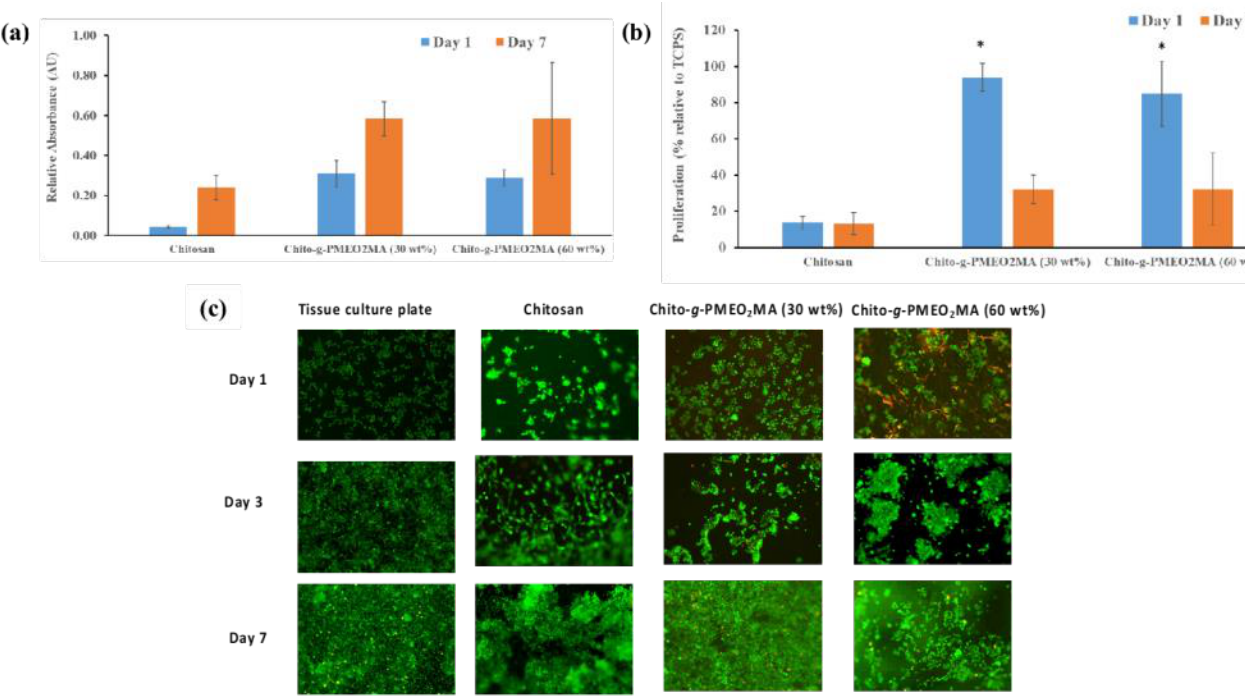
Figure 5. RAW 264.7 macrophages on TCPS, chitosan, and modified chitosan films. ( a ) Proliferation of RAW 264.7 cells on modified and unmodified chitosan films, relative absorbance of XTT in arbitrary units (AU). Mean ± SD, n = 4 or 5. ( b ) Proliferation of RAW 264.7 cells on chitosan films relative to the control surface (TCPS), as measured by XTT. Mean ± SD, n = 4 or 5; * indicates statistically significant from chitosan, p < 0.001. Note that statistical significance is not reported for